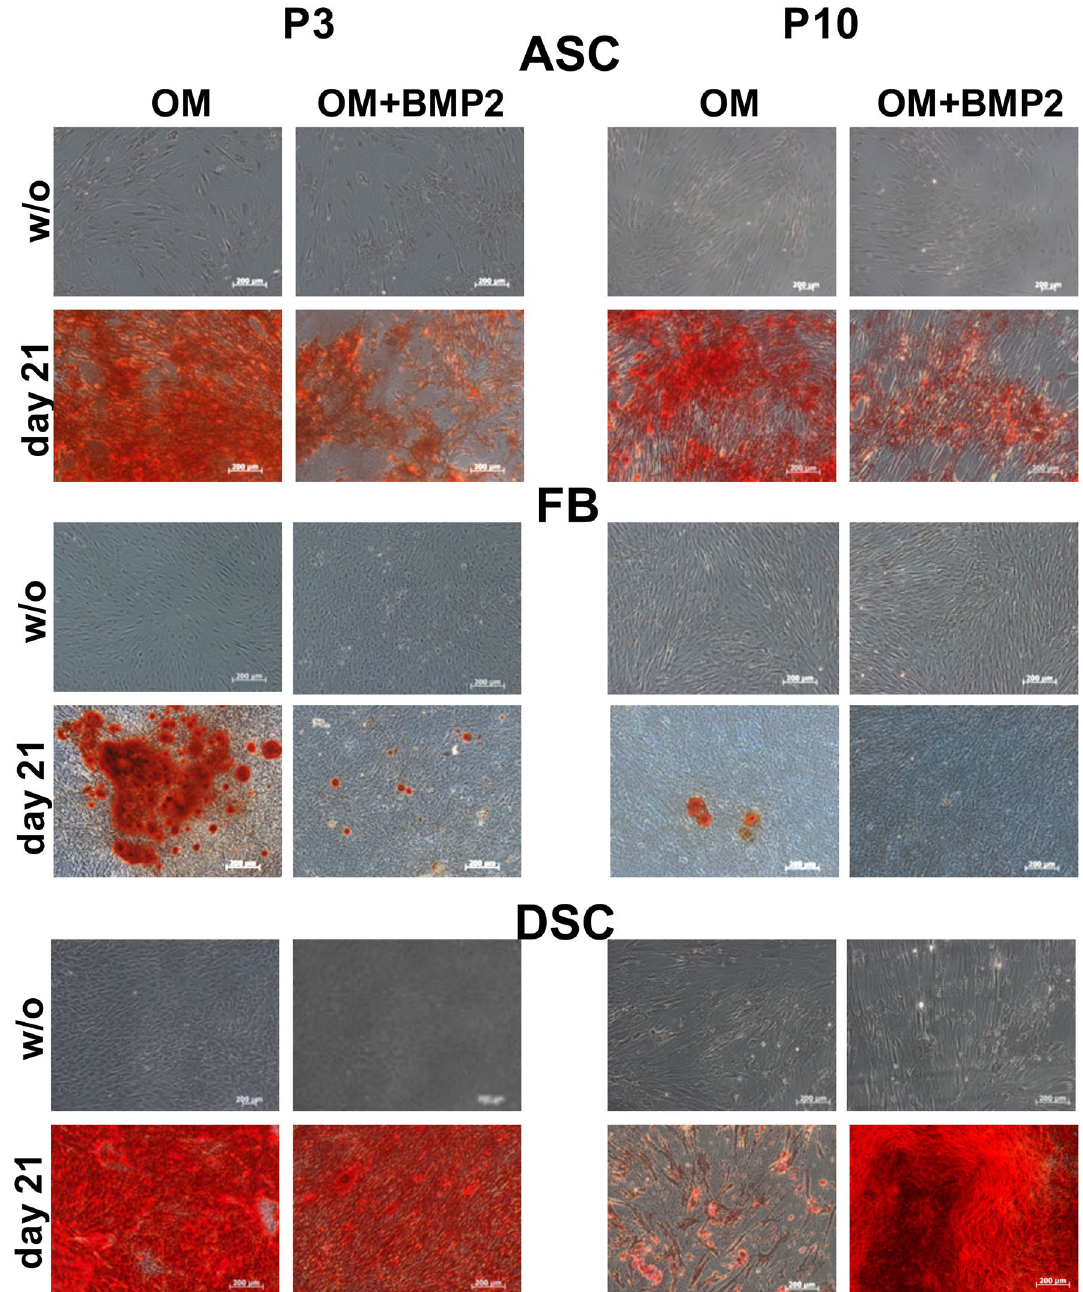
Figure 2. Microscopical analysis of the osteogenic differentiation potential at P3 compared to culture senescence cells at P10. Evaluation was performed with alizarin red s on day 0, and 21. Presented are the untreated controls (without: w/o), cell differentiated with osteogenic differentiation medium (OM) or cells differentiated with OM and supplemented with BMP-2 (OM + BMP2). Shown is one representative illustration of at least six identical results. The image scales represent a length of 200 µm. * p < 0.05 as compared to the respective sample of the culture of